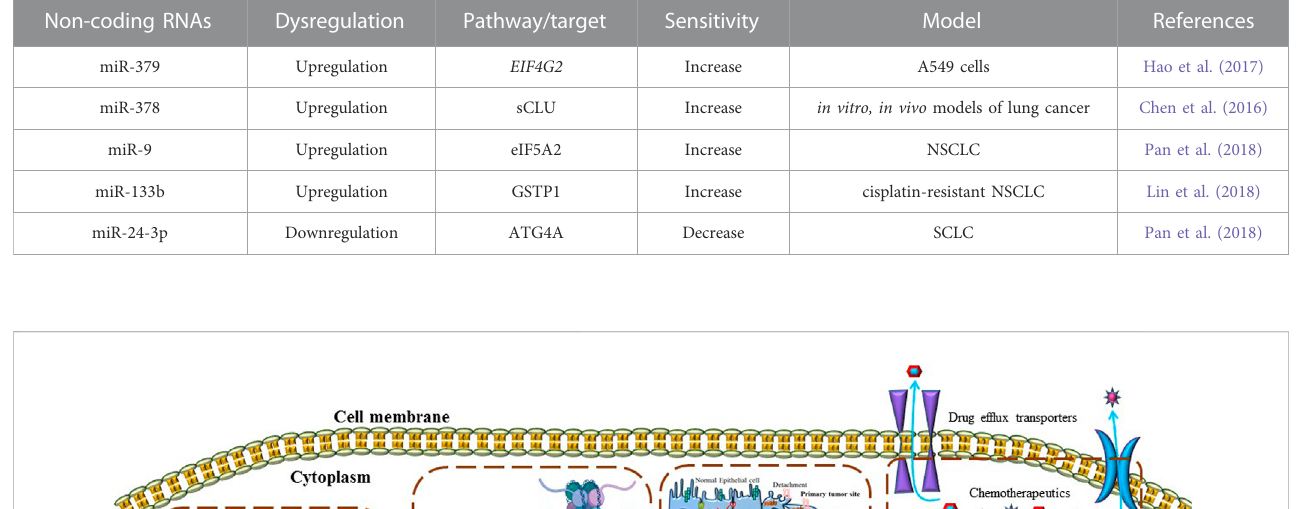
TABLE 6 Non-coding RNAs pro fi le alters the expression of others transcription factors involved in cisplatin-resistance. Non-coding RNAs